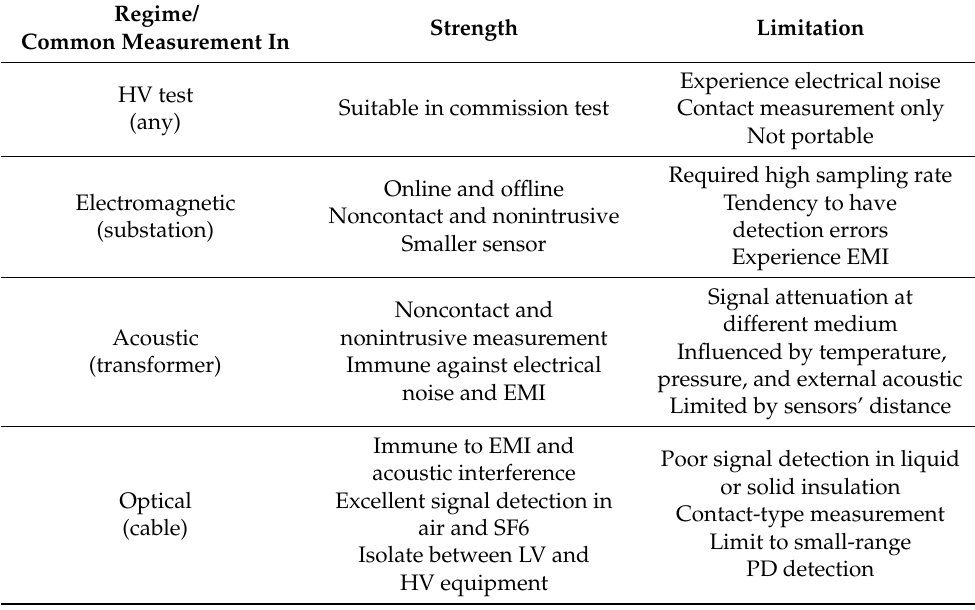
Table 2. Strength and limitations of PD detection for different